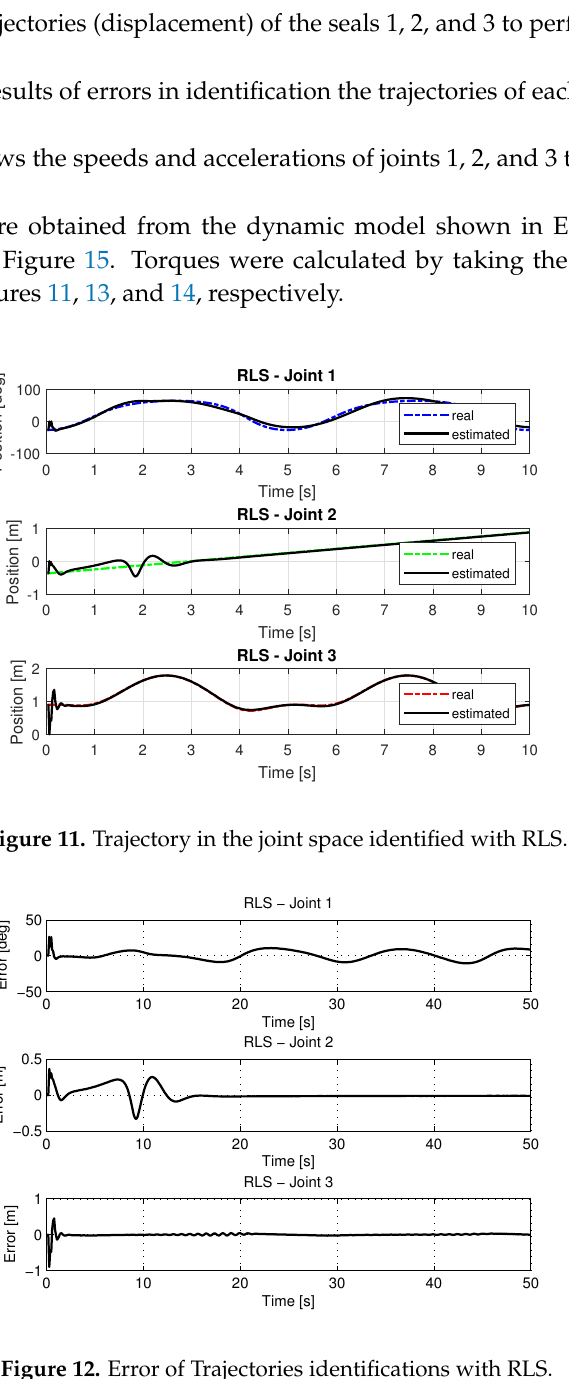
Figure 12. Error of Trajectories identifications with